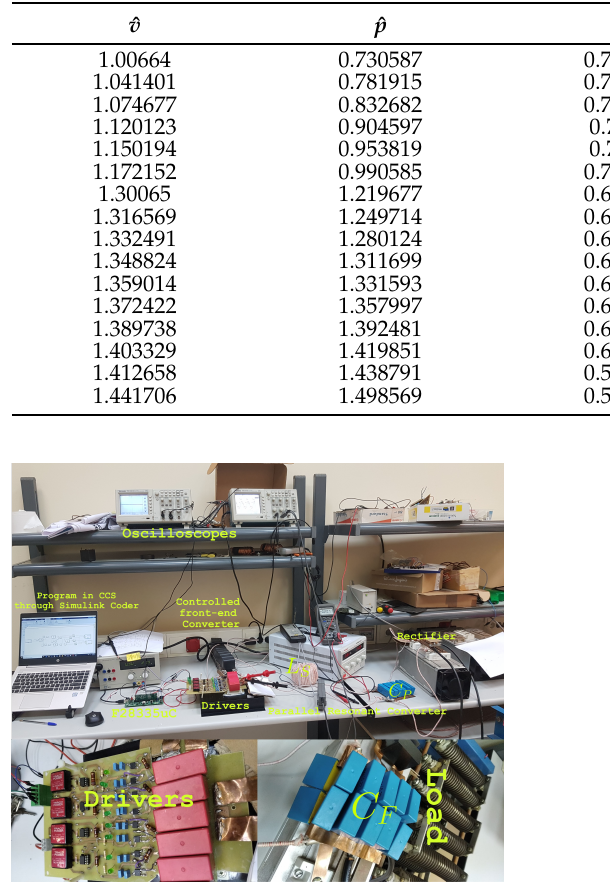
Figure 16. Illustration of the low-voltage